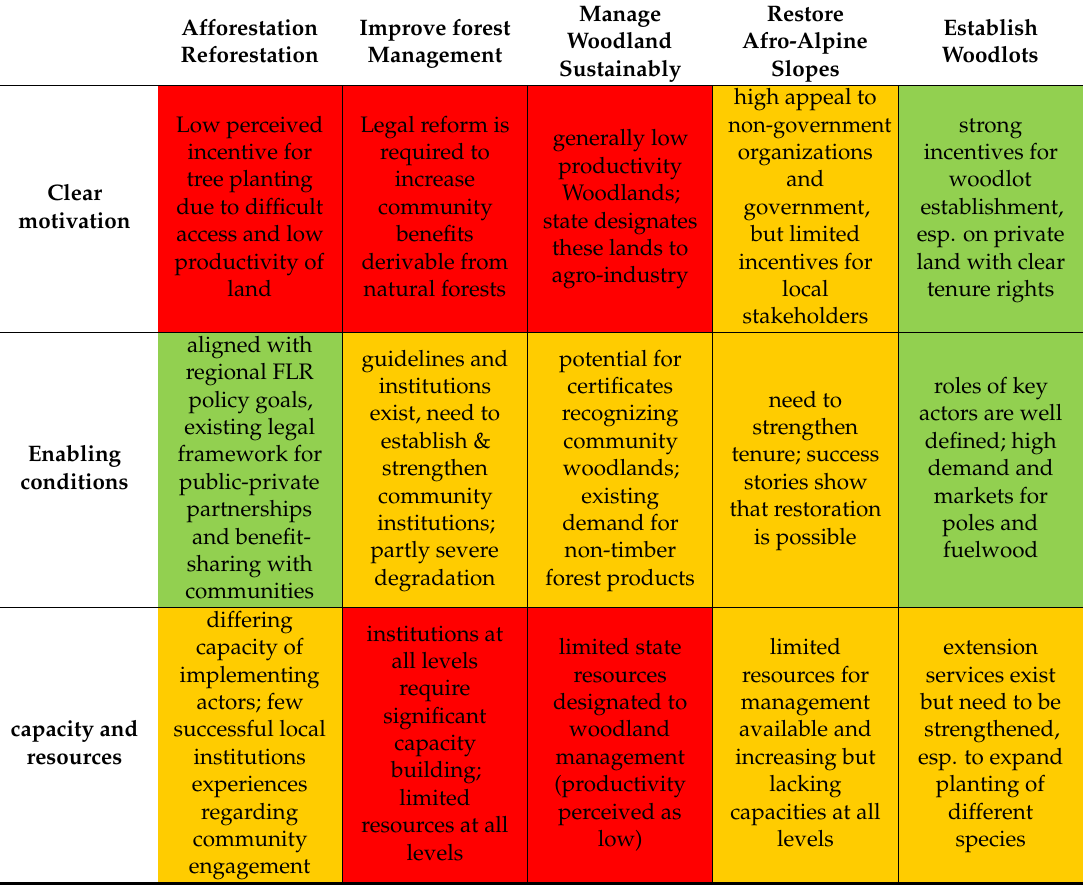
Table 5. Performance indicators of identified FLR options for ANRS according to the Landscape Restoration Diagnostic